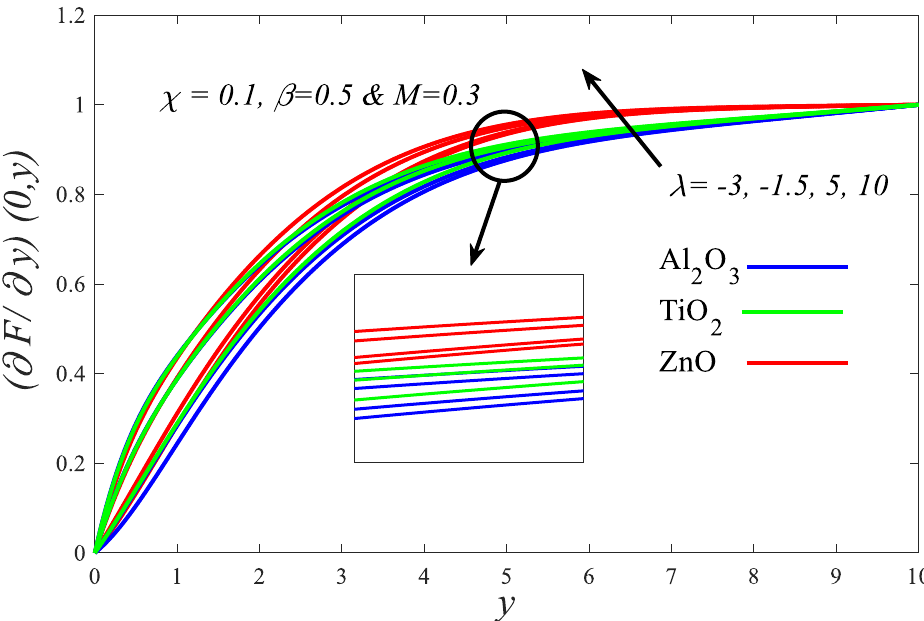
 Figure 11. Impression of on /   F y . The inset is a partial enlargement of the curves. Figure 11. Impression of λ on ∂ F / ∂ y . The inset is a partial enlargement of the curves. According to Figures 12 and 13, a growing nanoparticle volume fraction causes a heightening in the transmission of heat from outside of the cylinder’s surface to the fluid, which aids in raising the thickness of the thermal layer as a result of the augmentation in the temperature of the fluid. Besides, the rise in volume fraction of the nanoparticle for any of the employed reinforcer nanoparticles enhances the thermal conductivity of the host fluid, which results in the rate of heat transfer for the host fluid improving, consequently contributing to its increasing velocity, as is obviously seen in Figure 13.